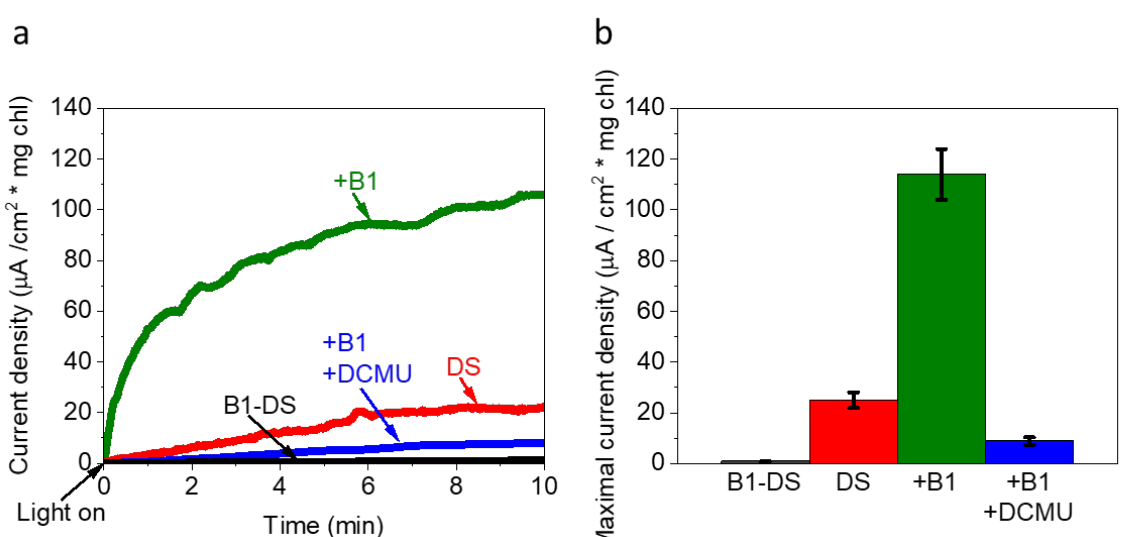
Figure 5. Vitamin B1 can mediate electrons from the photosynthesis pathway to the anode. CA of DS with the addition of vitamin B1 with or without DCMU was measured. ( a ) CA of vitamin B1 without Ds (black), Ds (red), Ds + vitamin B1 (green), and Ds + vitamin B1 + DCMU (blue). ( b ) Maximal current densities over 10 min of CA measurements. The error bars represent the standard deviation over three independent measurements. Values obtained in the absence of Ds were multiplied by the chlorophyll concentration value used to normalize the samples that contain Ds.